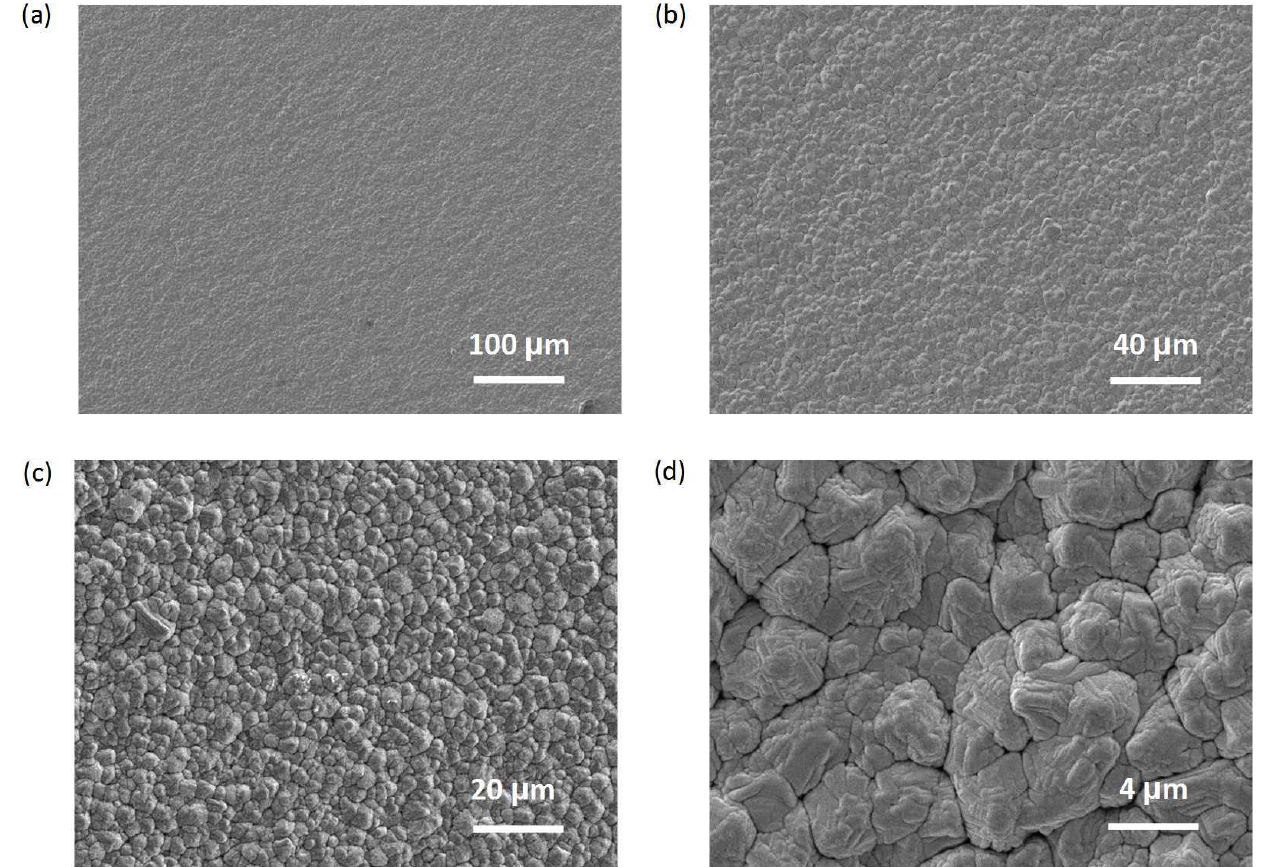
Figure 4. SEM images of surface Ge composite film with different magnification: ( a ) 200 times, ( b ) 500 times, ( c ) 1000 times, and ( d ) 5000 times.